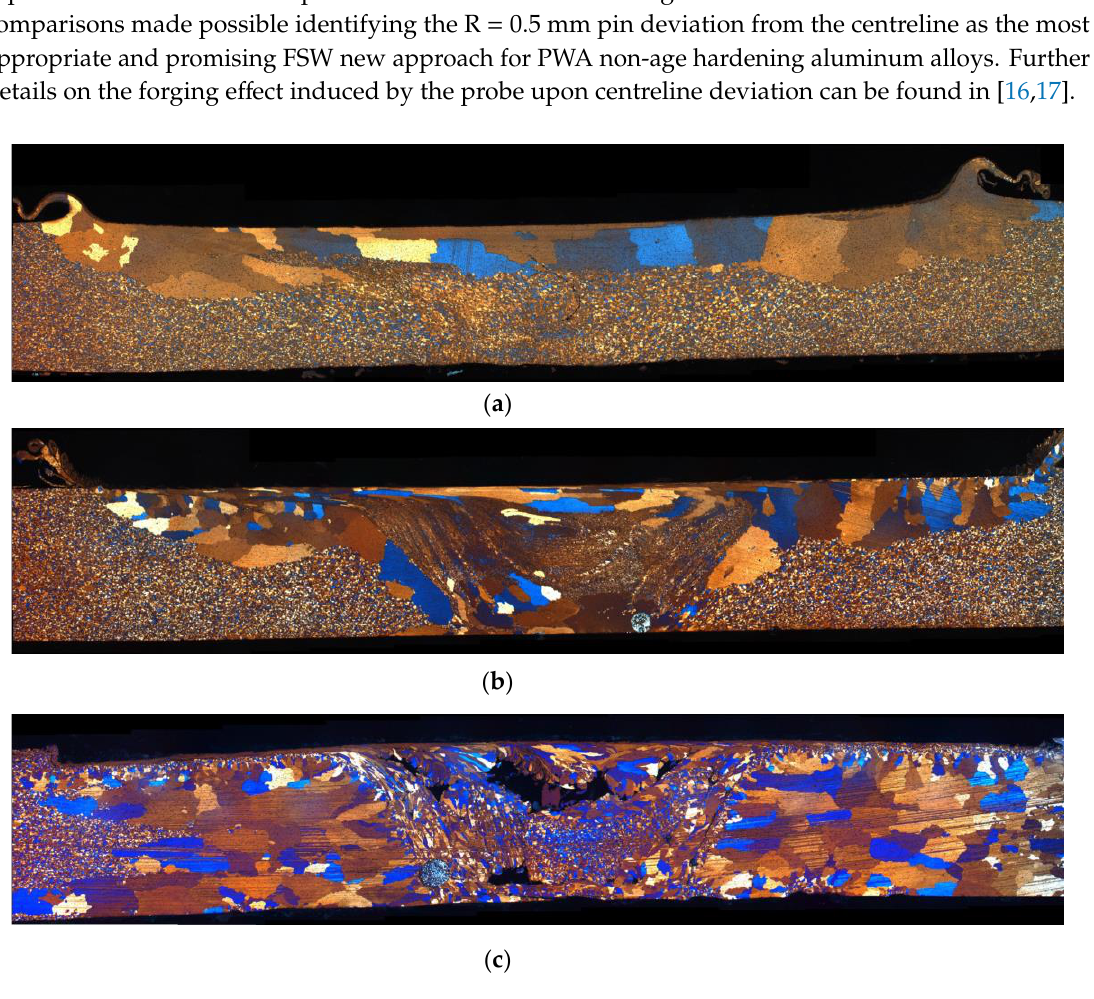
Figure 12. Montage of POM images of joints in AA5754 alloy obtained by performing FSW and post-welding annealing treatment (PWA at 415 °C/3 h, followed by furnace cooling). The effect of pin deviation from welding line on microstructure of joints: ( a ) R = 0 mm, ( b ) R = 0.5 mm and ( c ) R = 1 mm.